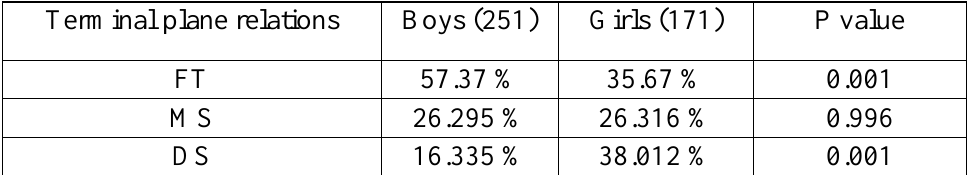
Table 6: gender differences in the presence of different types of terminal plane relations.